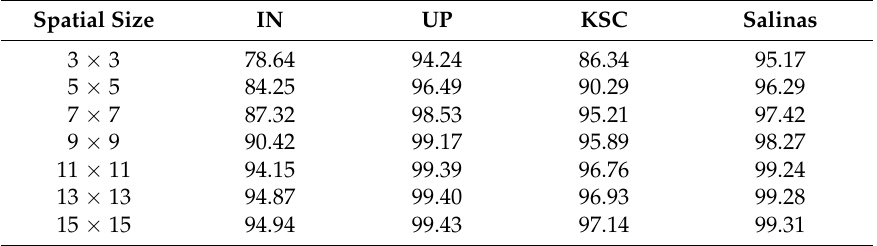
Table 5. Classification results (OA%) of our methods on the four data sets with different input sizes. Spatial Size IN UP KSC Salinas 3 × 3